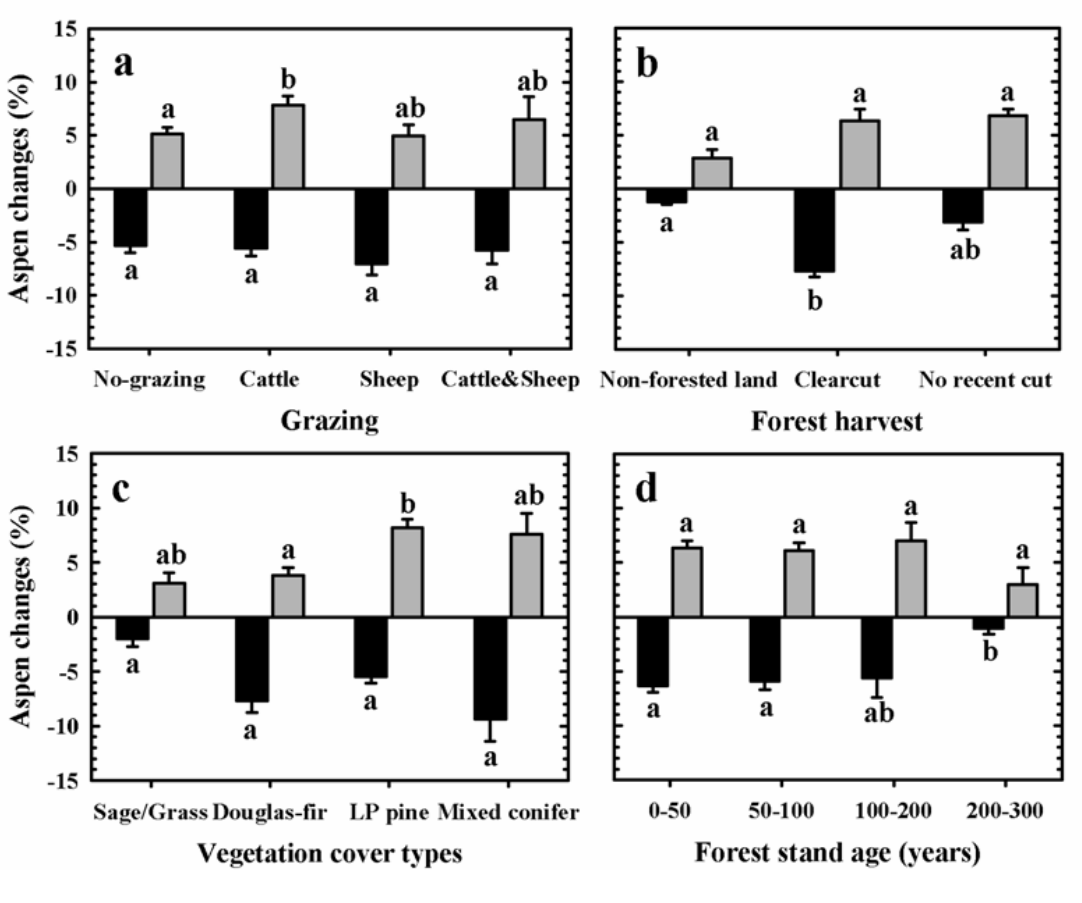
Figure 7. Aspen change patterns in the 1987–2005 time period. Aspen increase (positive grey bars) and aspen decrease (negative black bars) were simultaneously analyzed as two response variables in a MANOVA model. Grazing and vegetation cover types were statistically significant predictor variables in aspen increase (p < 0.05), while forest harvest and stand age were significant in aspen decrease (p < 0.05). (a) Aspen changes patterns and grazing; (b) Aspen change patterns and forest harvest; (c) Aspen change patterns and vegetation cover type (LP pine = Lodgepole pine); (d) Aspen change patterns and forest stand